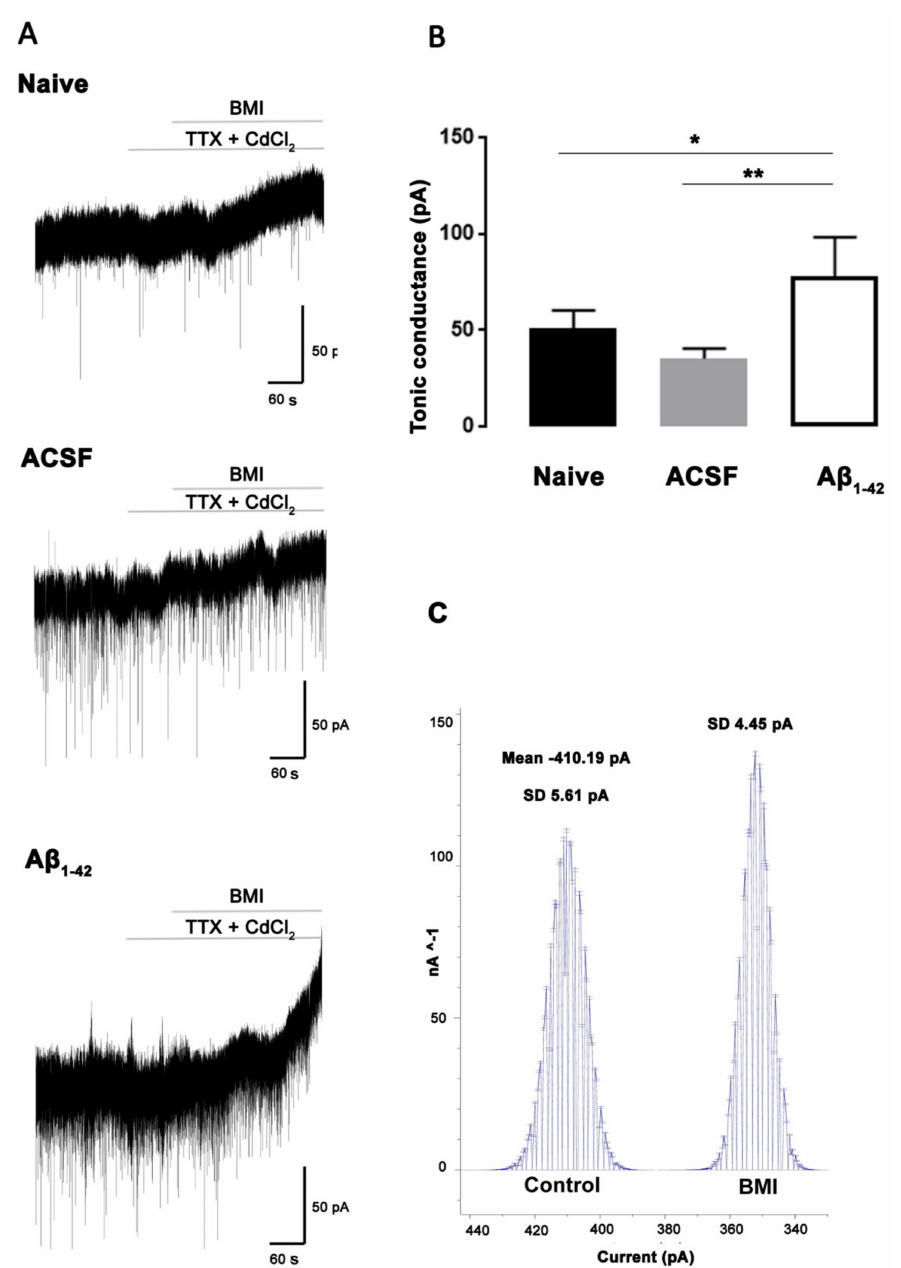
Figure 1. A β 1-42 -induced increase in gamma-aminobutyric acid (GABAergic) tonic conductance in CA1 pyramidal cells. ( A ) Representative whole cell traces from voltage-clamp recording of CA1 pyramidal cells (PCs) (Vh = − 70 mV) from naïve control (NC), artificial cerebrospinal fluid (ACSF) -injected and A β 1-42 -injected mice in the presence of 3 mM kynurenic acid and 5 µ M GABA. The lines above the traces indicate the points at which TTX (5 µ M) + CdCl 2 (50 µ M) and bicuculline methiodide (BMI) (100 µ M) were applied. ( B ) Histogram plot of tonic current measured in the NC, ACSF-injected and (* p = 0.0382, ** p = 0.0025; NC n = 4, ACSF-injected n = 4, and A β 1-42 -injected n = 5). ( C ) For a